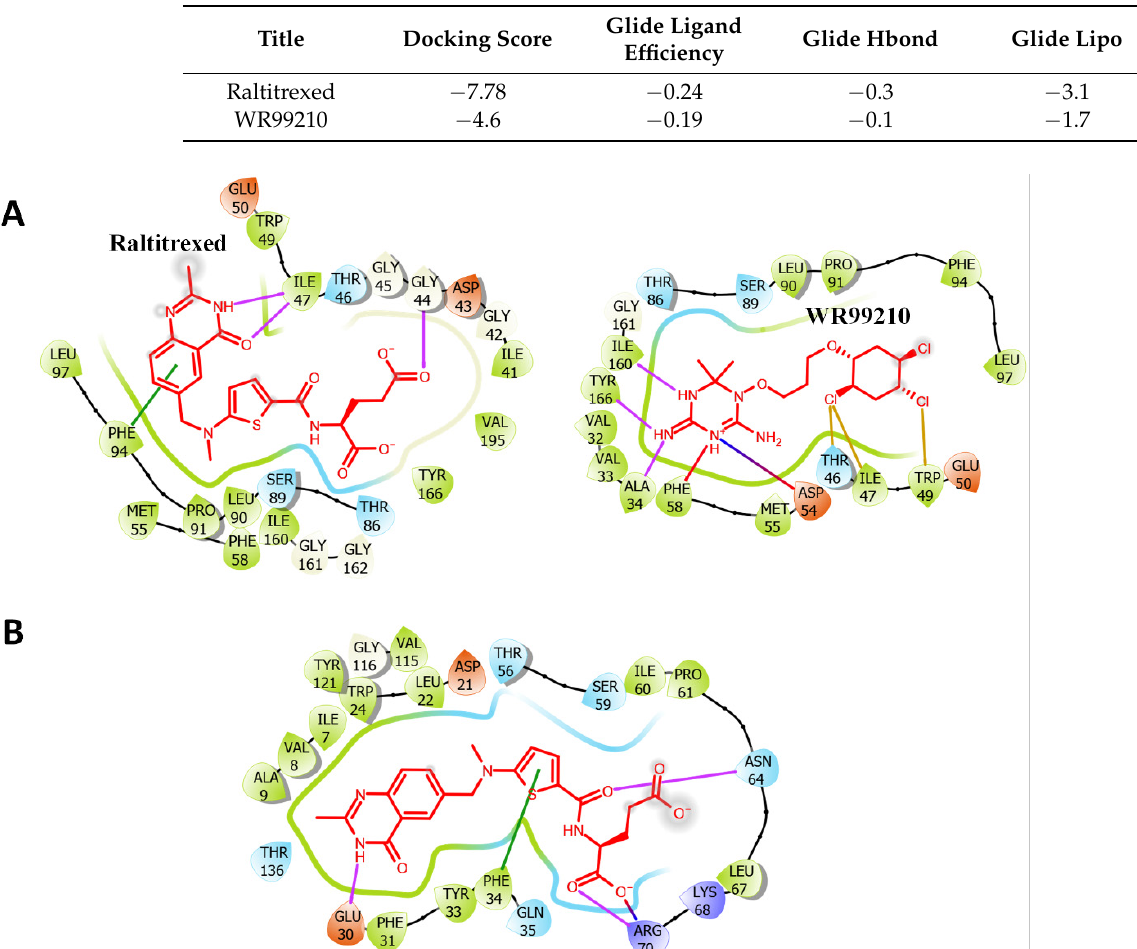
Figure 2. The ligand interactions and docking site of raltitrexed with DHFR. ( A ) The ligand interac- tions of raltitrexed with Trypanosoma brucei dihydrofolate reductase. ( B ) The docking site of ral- titrexed with Humans dihydrofolate reductase. Hydrogen bonds in violet arrows, pi-pi stacking in green sticks, salt bridges in multicolored sticks and halogen bonds in amber. ( C ) Pairwise alignment of human (1DFR) and T. brucei (3RG9) DHFR. The different residues are highlighted in pink. ( D ) Pairwise comparison statistics of human (1DFR) and T. brucei (3RG9) DHFR. The number of amino acid differences is highlighted in red. The identity% is highlighted in blue. 3.3. Molecular Dynamics Simulations